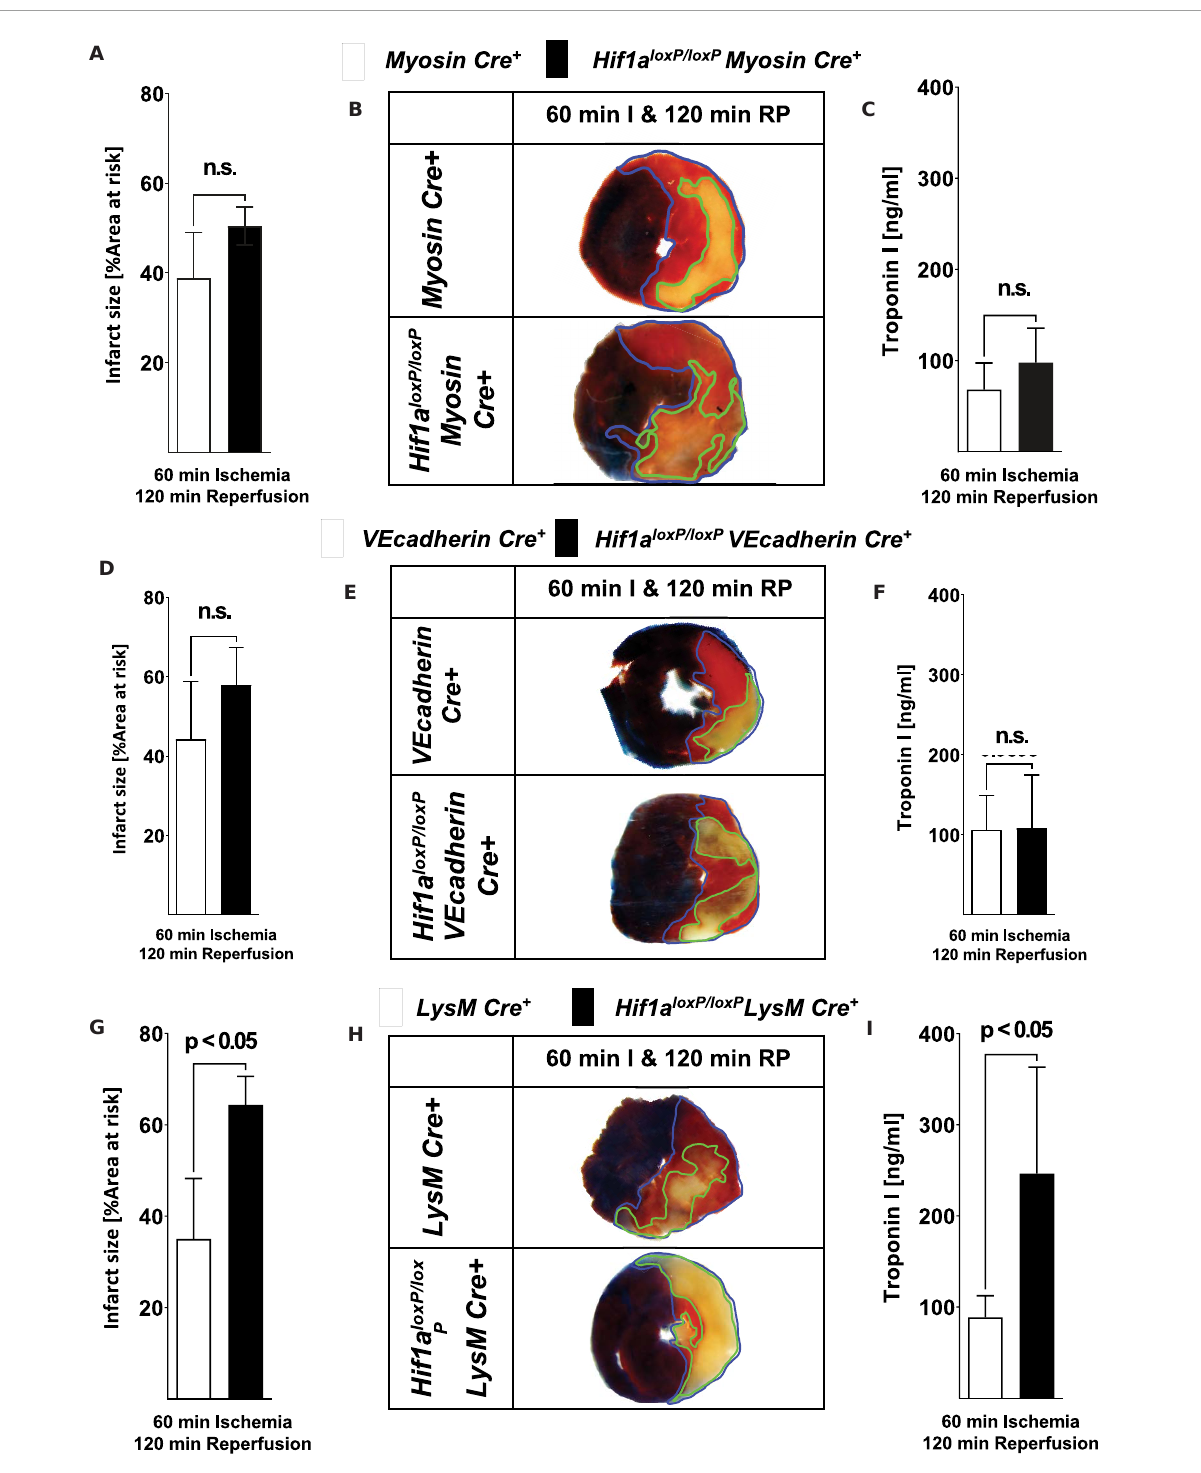
FIGURE2 Myocardial ischemia and reperfusion injury in mice with tissue-specific Hif1a deletion in cardiac myocytes, vascular endothelia, or myeloid inflammatory cells. (A–I) Hif1a loxP / loxP were crossed with mice expressing Cre-recombinase under the control of heavy chain myosin promoter including a tamoxifen inducer ( Hif1a loxP / loxP Myosin Cre+ mice) (23), vascular endothelial cadherin ( Hif1a loxP / loxP VEcadherin Cre+ mice) (27). ( Hif1a loxP / loxP VEcadherin Cre+) or lysozyme 2 ( Hif1a loxP / loxP LysM Cre+ mice) (42) to generate tissue-specific HIF1A-deficient animals. Mice underwent 60 min of myocardial ischemia, followed by 120 min of reperfusion. Myocardial injury was determined by area at risk and troponin I serum concentration in Hif1a loxP / loxP Myosin Cre+ mice and age, sex, and weighed Myosin Cre+ mice who were matched